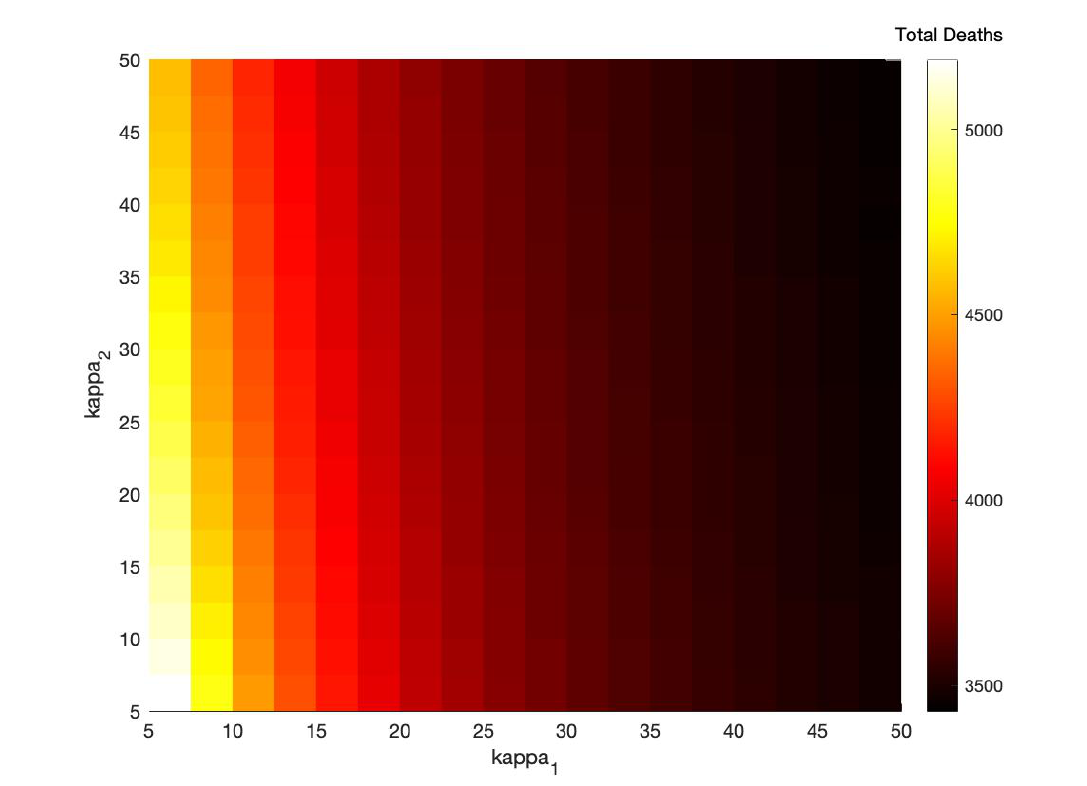
Figure 6. Effect of varying contact tracing parameters κ 1 and κ 2 on the total number of deaths by day 504 of the